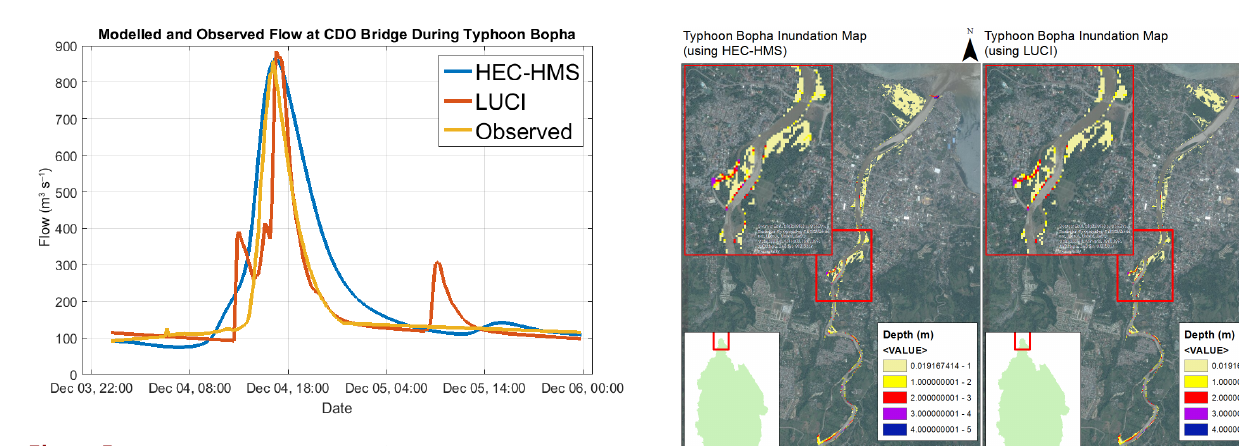
map based on the LUCI hydrograph is also similar to the in- undation map based on the HEC-HMS